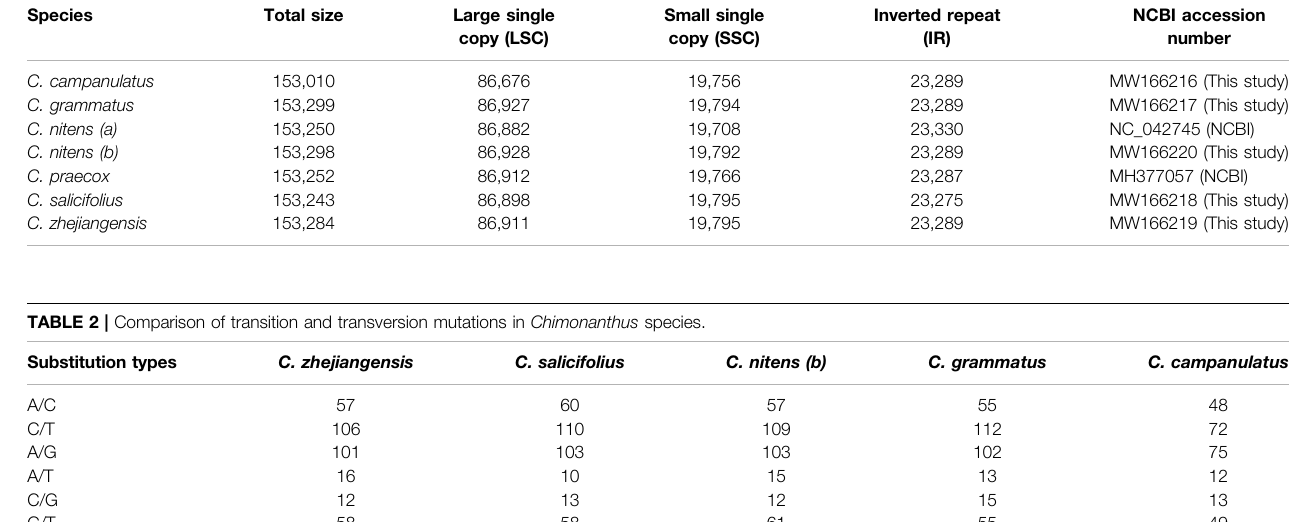
TABLE 1 | Sizes (bp) of different regions of the assembled chloroplast genomes. Species